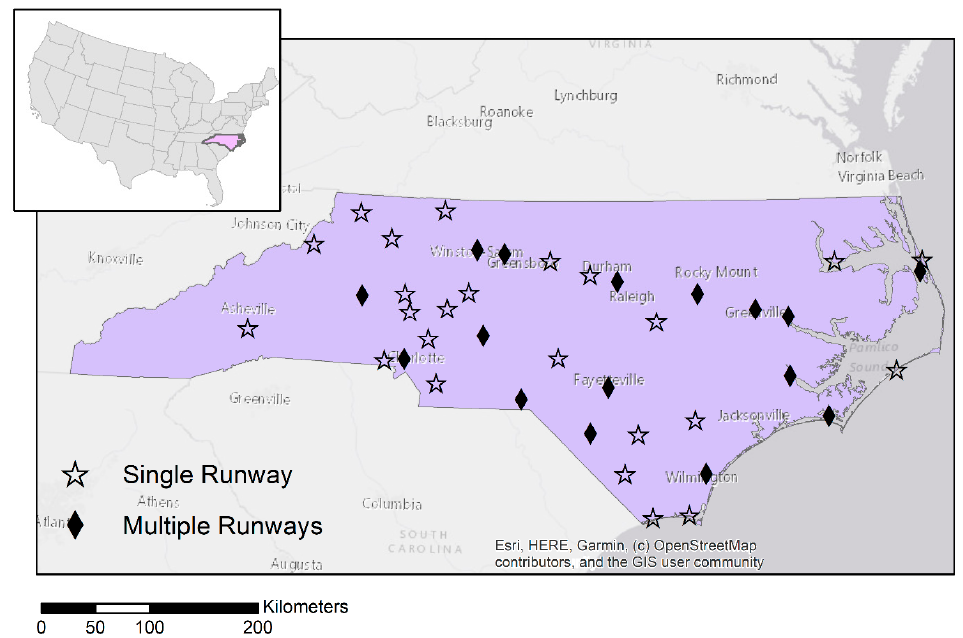
Figure 1. North Carolina airports with flight operations data available and populations located within 2 km.